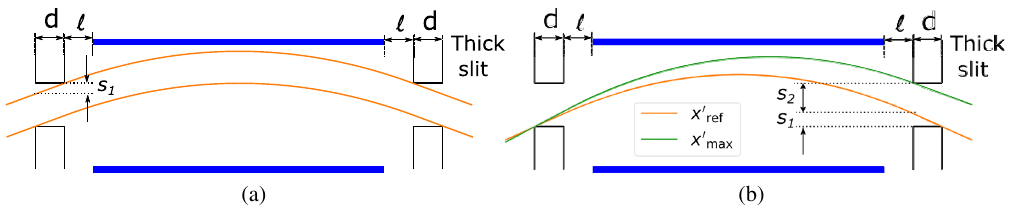
FIG. 14. How (a) shifting a trajectory for fixed angle and (b) changing the angle for fixed initial position allow one to calculate quantities listed in Table